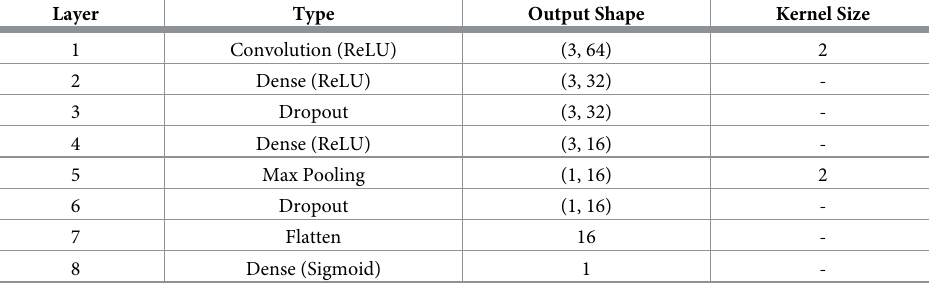
Table 3. CNN model structure for the tumor detection model with input features. Layer